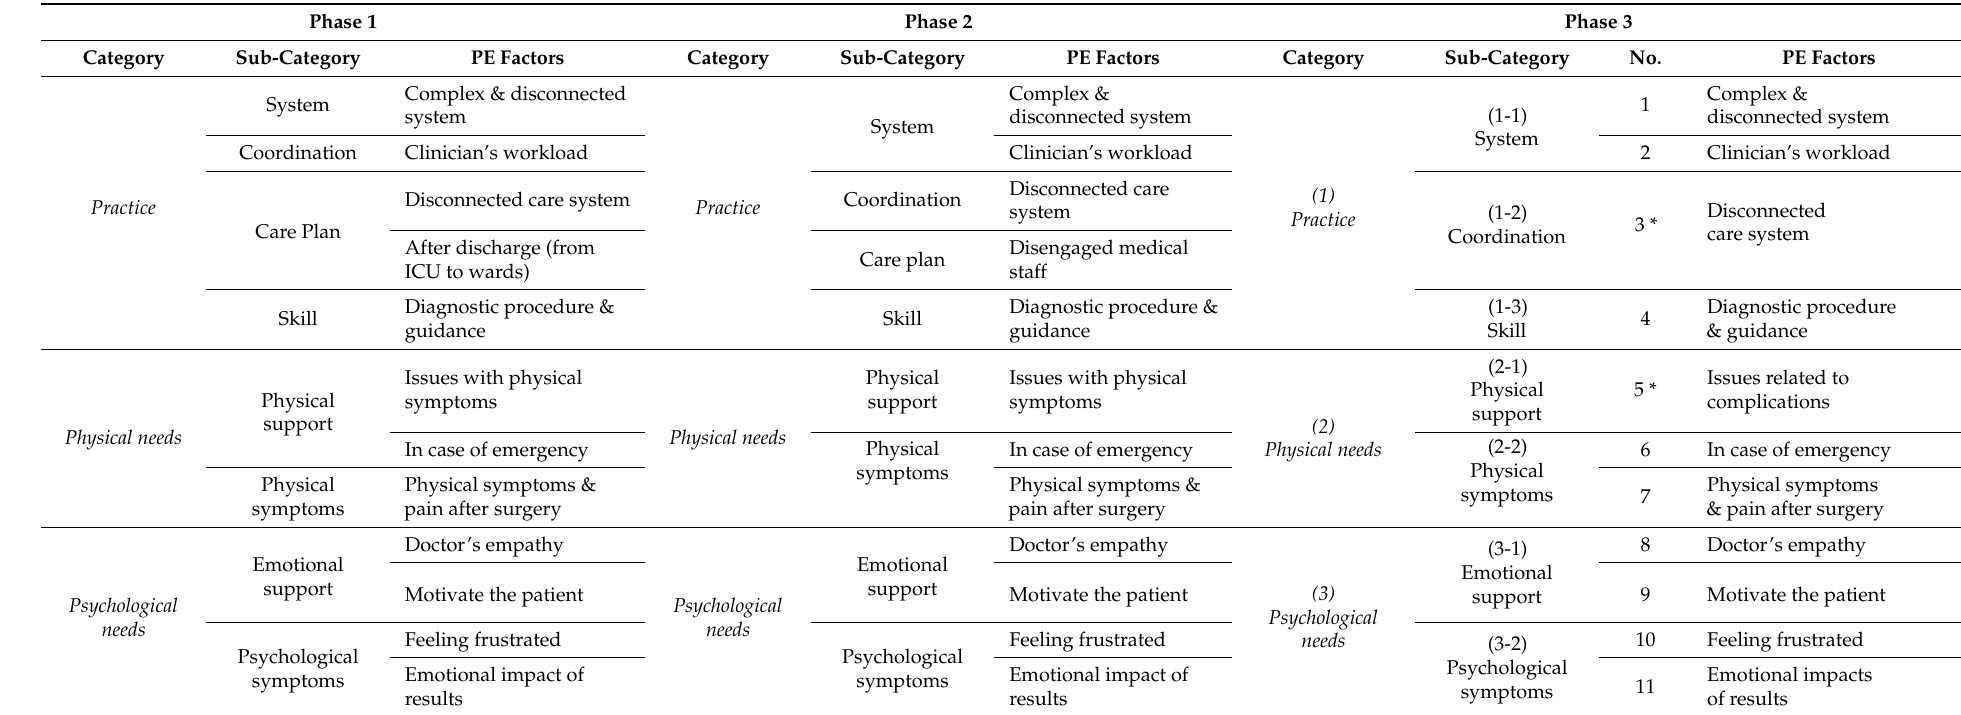
Table 2. The list of Pat Exp Insight Cards for patients with HNC developed by phases